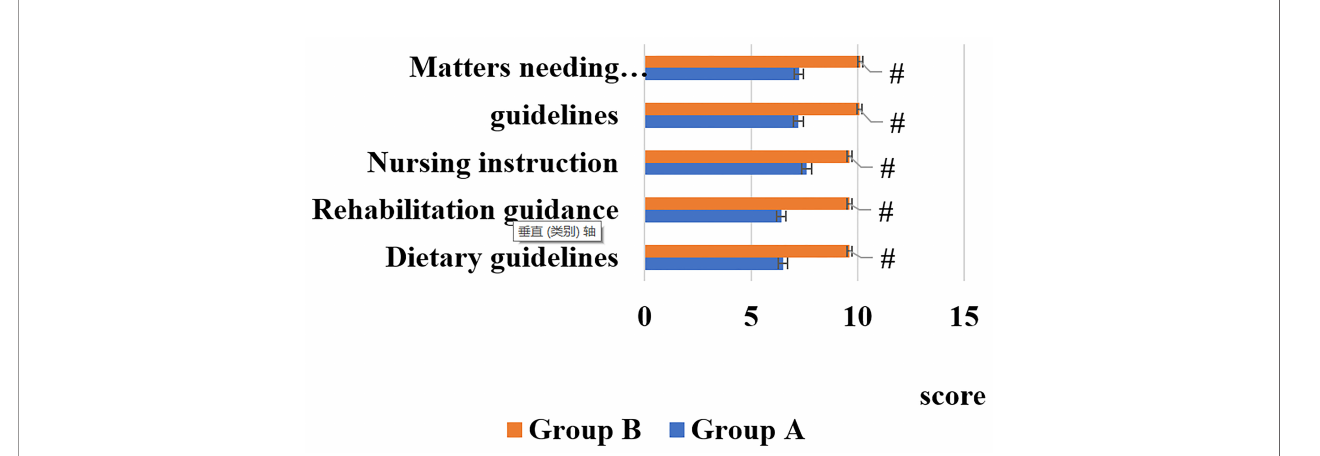
FIGURE 1 | DKM of patients. [# indicated that compared with group A, the difference was statistically signi fi cant ( P <